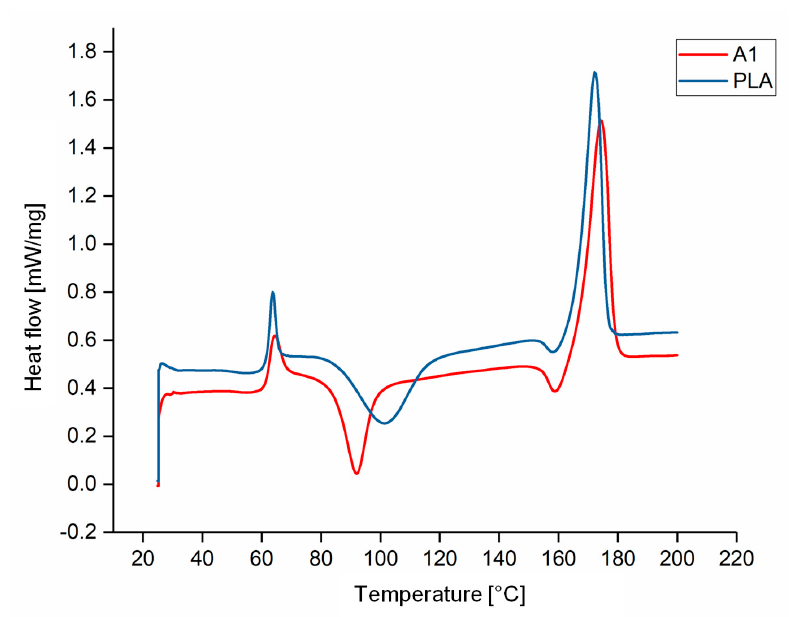
Figure 5. DSC thermogram of PLA and compound A1.